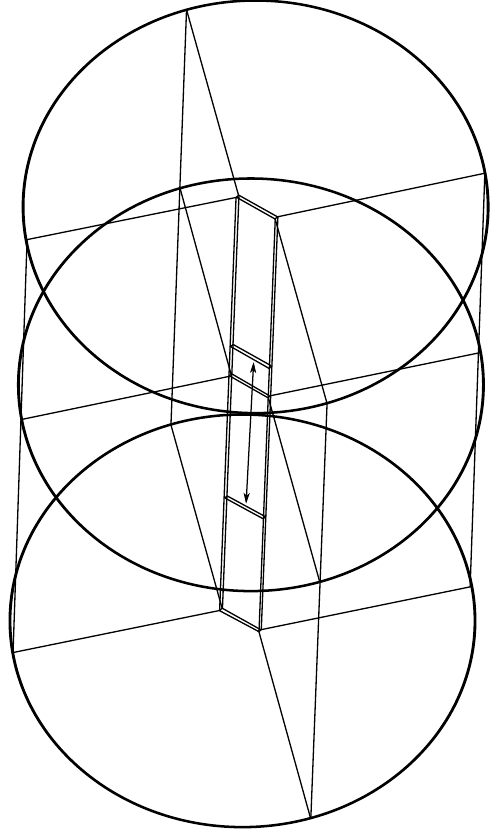
Fig. 4. FEM analysis computational domain (line with arrow ends indicates the plate submersion movement during consecu- tive simulations. Position of the plate in the picture is 440 mm submersion.